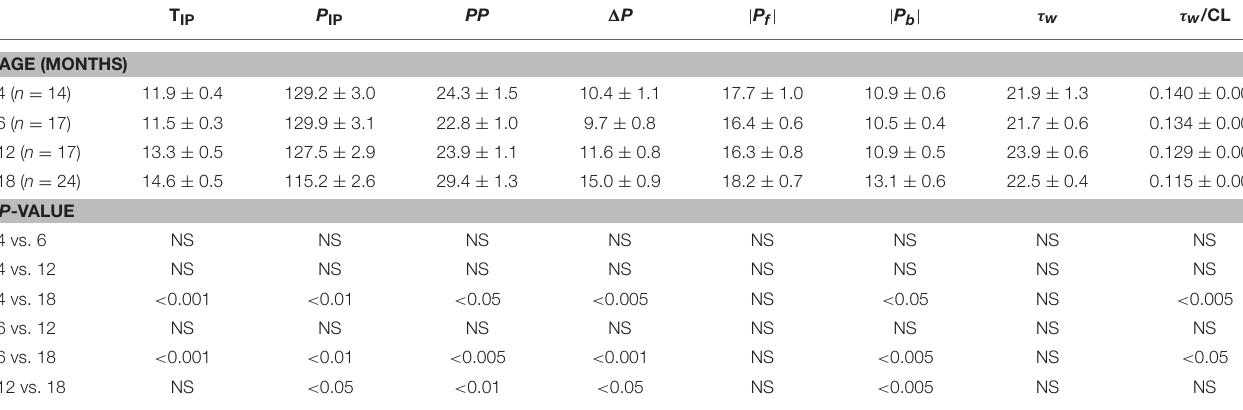
TABLE 2 | Characteristics in relation to pulse wave reflection derived from aortic pressure waveform in rats aged 4, 6, 12, and 18